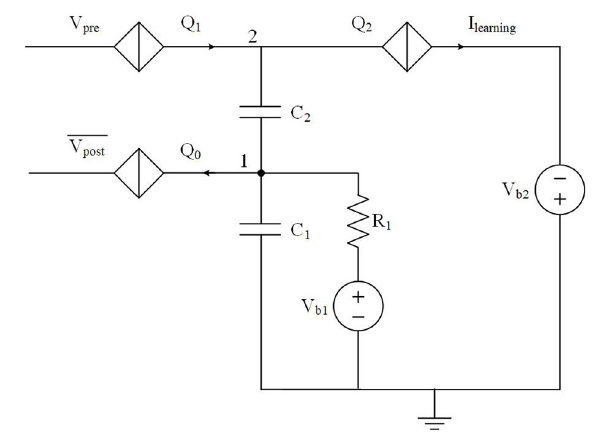
FIGURE 4 | An LTD circuit that generates depression pulses to a synapse. A pulse will be generated at I learning when the timing difference 1 t = t post − t pre is within a short learning